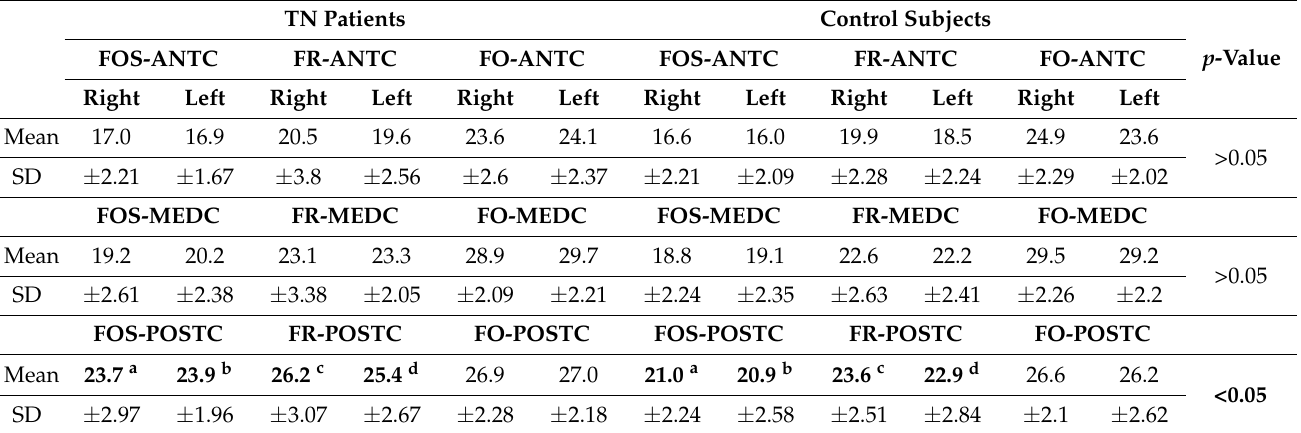
Table 4. The distances between the superior orbital fissure, rotundum, and ovale foramen to the anterior, middle, and posterior clinoid processes in trigeminal neuralgia patients and control subjects. The same letters indicate statistical significance which is less than 0.05.